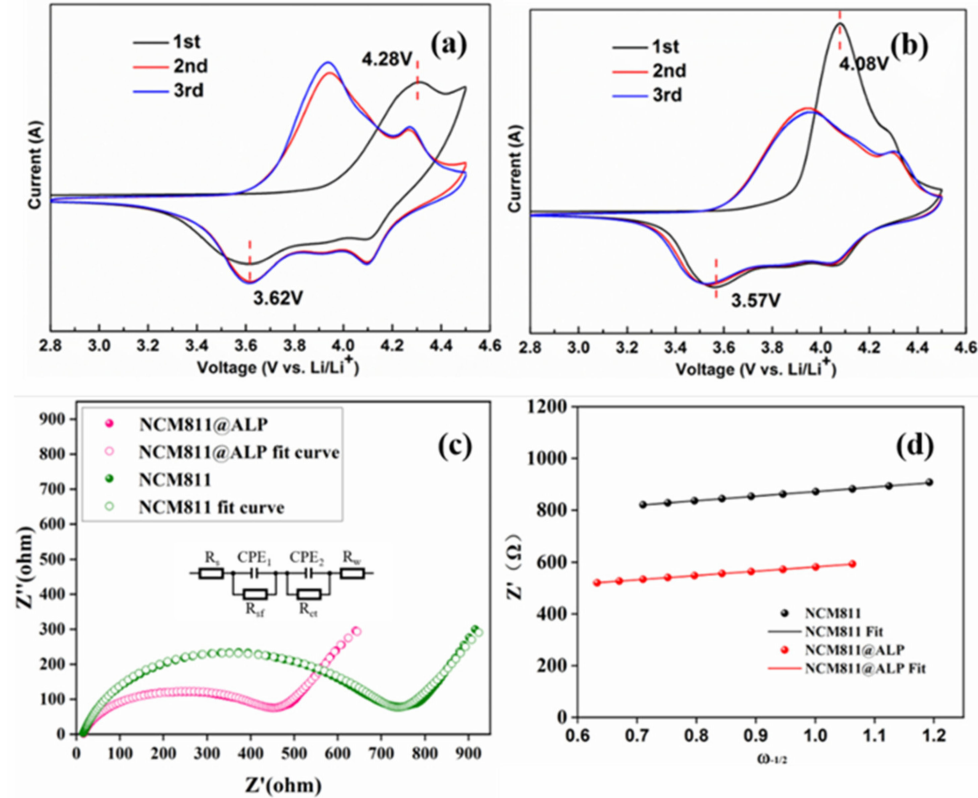
Figure 6. ( a ) CV profiles for NCM811 in the first three cycles. ( b ) CV profiles for NCM811@ ALP 500 in the first three cycles. ( c ) Nyquist plots and the fitted Nyquist plots with equivalent circuit (insert graph) for NCM811 and NCM811@ ALP 500 electrodes after 200 charge–discharge cycles. ( d ) The relationships between Z (cid:48) and ω − 1/2 based on ( c